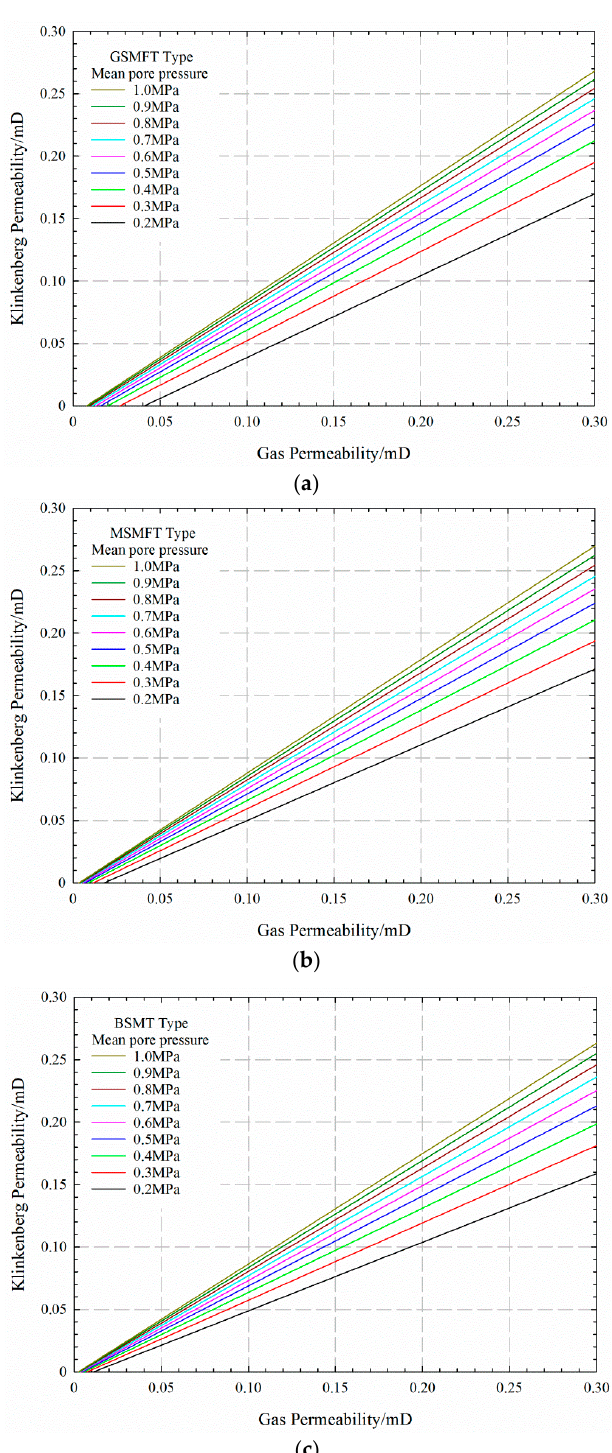
Figure 14. Calculated Klinkenberg permeability using equations versus measured Klinkenberg permeability.